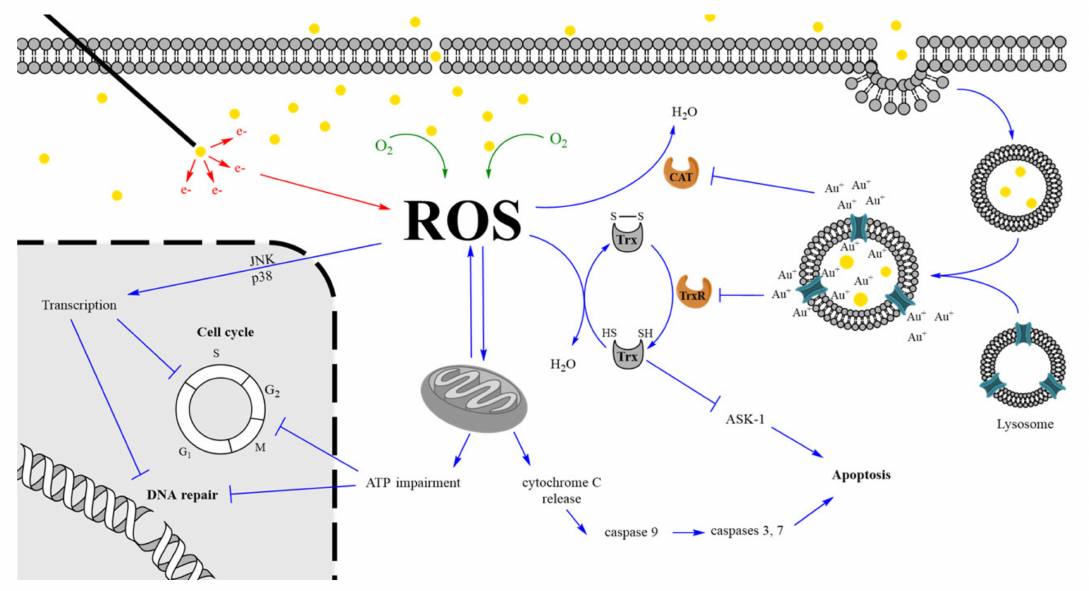
Figure4. Schematicrepresentationoftransdisciplinarymechanismresponsiblefortheradiosensitization e ff ect of GNPs through interaction with cells. Physical dose enhancement, chemical enhancement, and biological mechanisms are illustrated by red, green, and blue lines, respectively. CAT = catalase; TrxR = thioredoxin reductase; Trx = thioredoxin; e- =